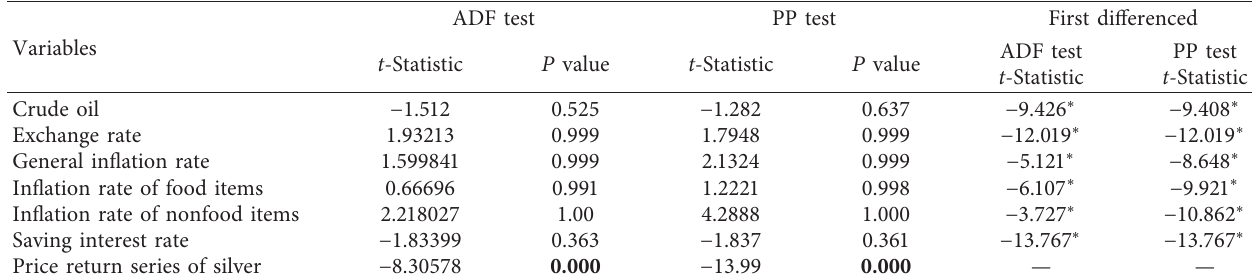
Figure 1: The price trend and absolute monthly return series of silver over the study period. Table 2: The ADF and PP unit root tests at level and first differenced for the series.